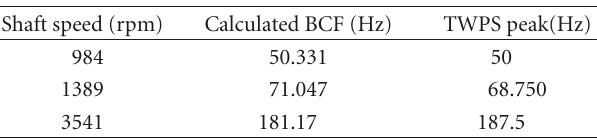
Shaft speed (rpm) Calculated BCF (Hz) TWPS peak(Hz) 984 50.331